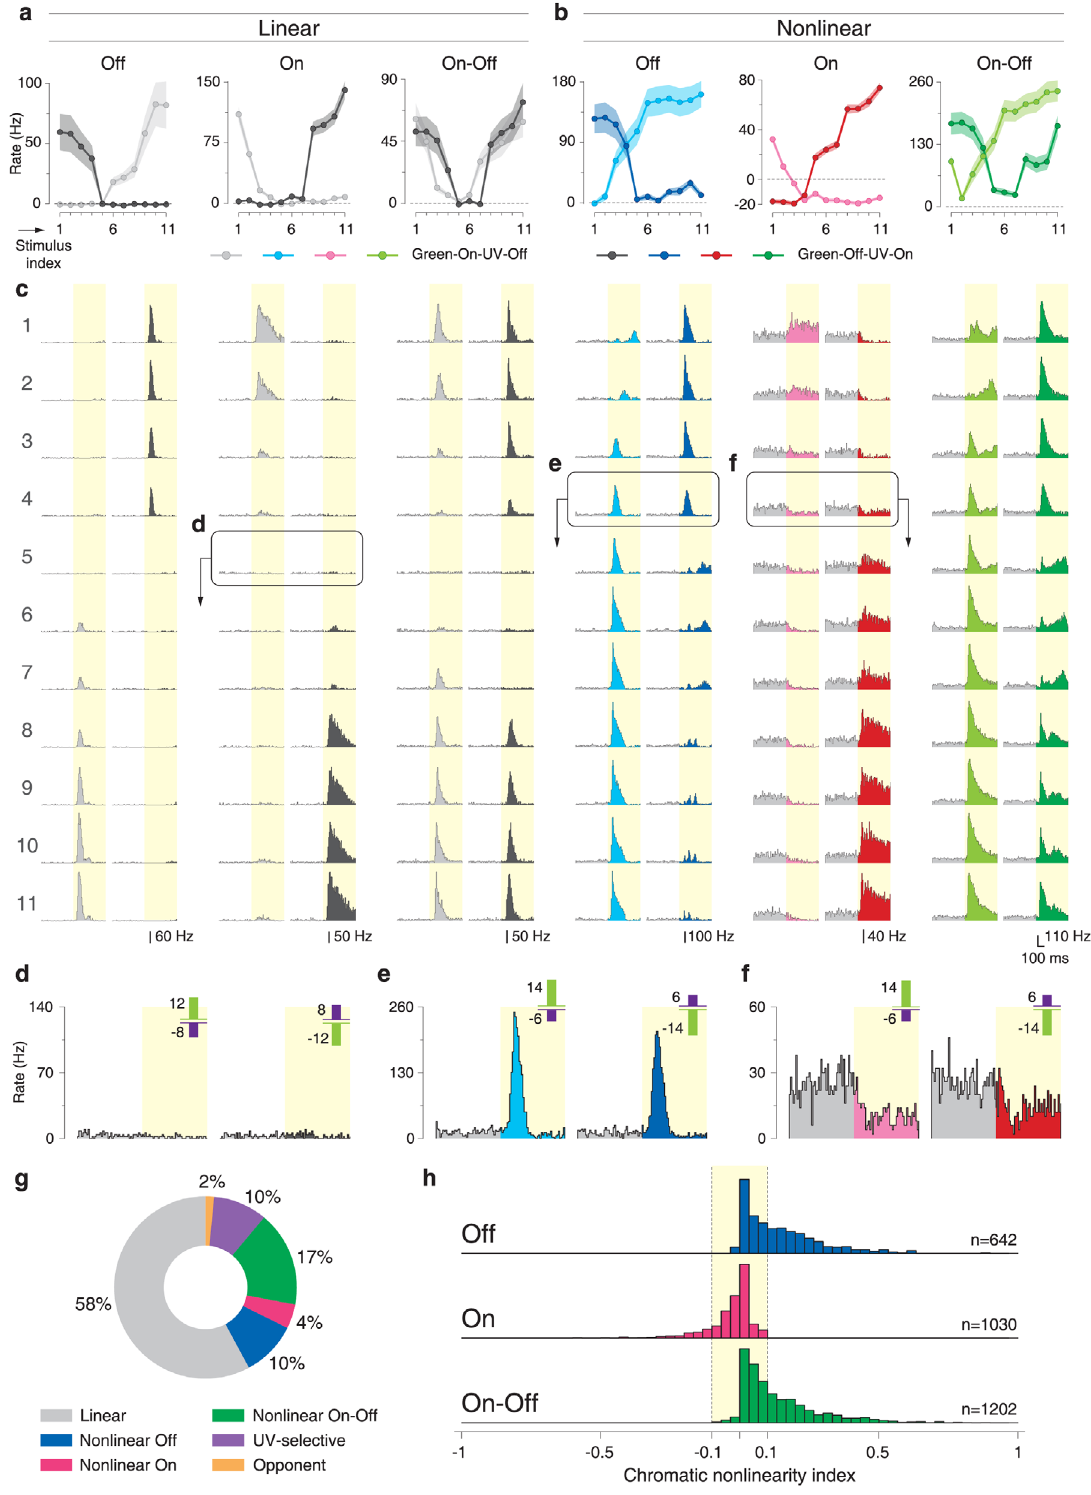
Fig. 3 Different patterns of nonlinear chromatic integration in On and Off cells. a Responses of sample linear Off, On, and On – Off cells to the chromatic- integration stimulus. Shaded regions around the curves show mean ± SEM. b Reponses of sample nonlinear Off, On, and On – Off cells to the chromatic- integration stimulus. Note that the nonlinear On cell, unlike the other two cells, showed activity suppression at the balance point. Shaded regions around the curves show mean ± SEM. c PSTHs for the six sample cells in a and b for all contrast combinations of the chromatic-integration stimulus. d – f PSTHs in response to stimuli near the balance point for a sample linear cell ( d ), the sample nonlinear Off cell ( e ), and the sample nonlinear On cell ( f ). g Relative proportions of linear and nonlinear cells among all the recorded ganglion cells. h Distributions of chromatic nonlinearity indices for Off, On, and On – Off